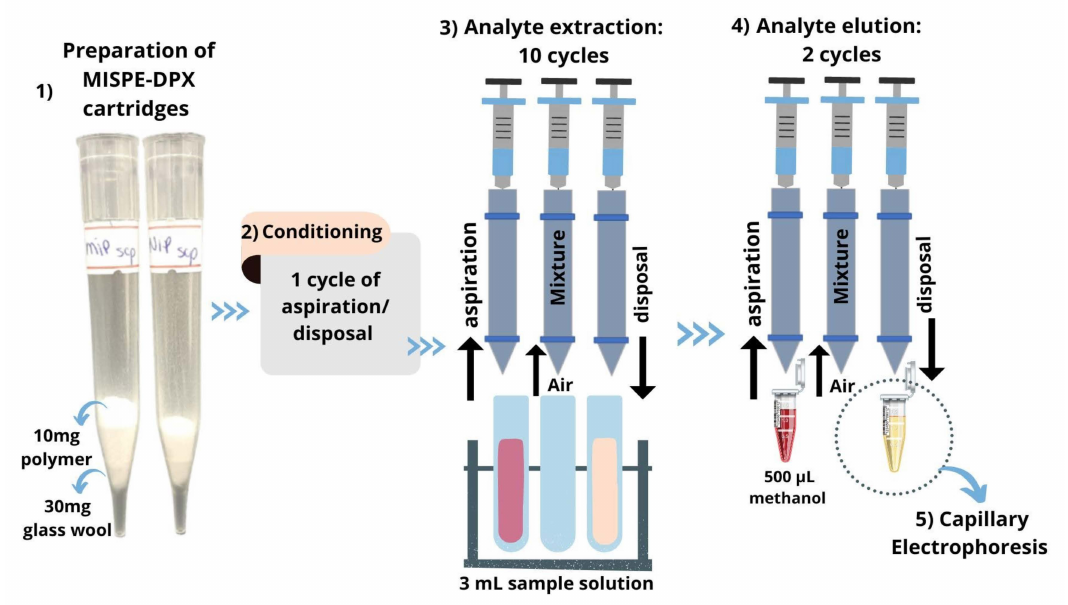
Figure 1. Representative diagram of the steps from the preparation of the cartridges to the elution of the